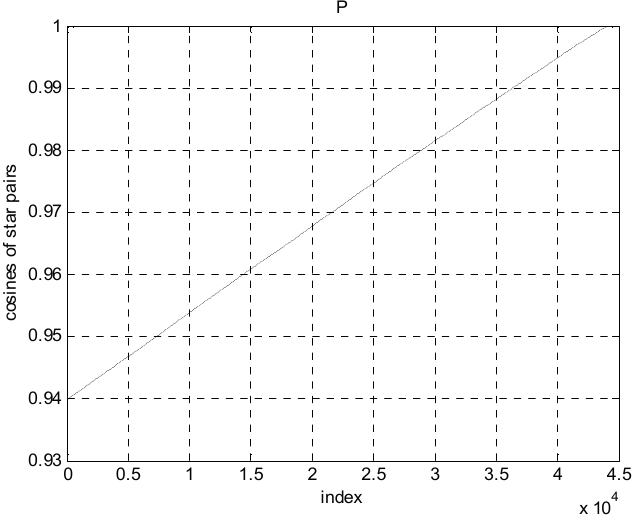
Figure 4. P as a function of